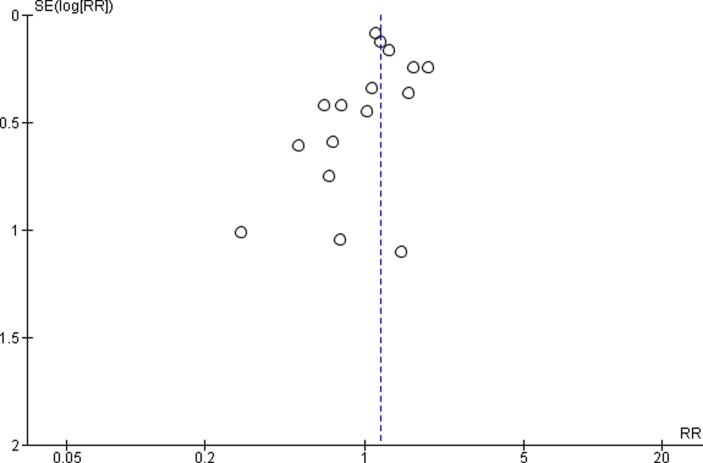
Funnel plot of prioritized evidence (cohort studies), Outcome: Died from ischaemic heart disease, Comparison: Worked ≥55 h/week compared with worked 35–40 h/week.